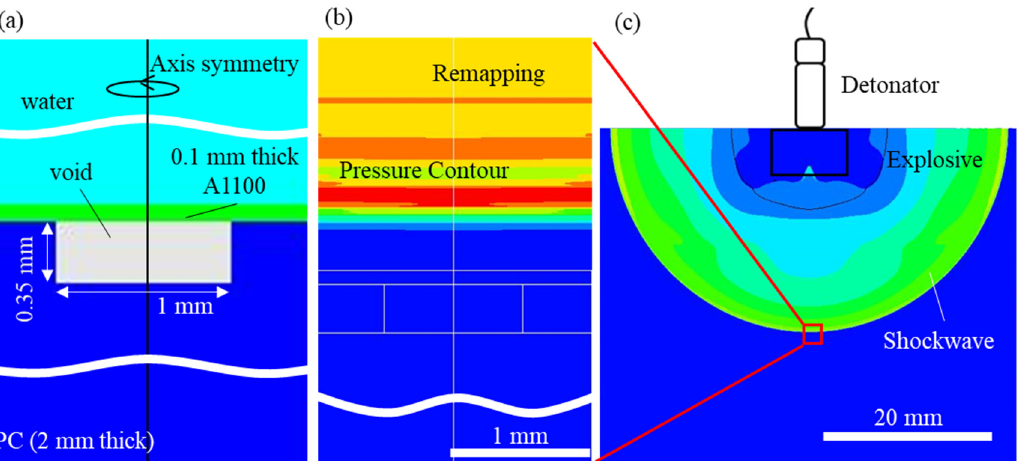
Figure 3. Numerical-simulation model using 2D Lagrangian and Eulerian solvers. ( a ) Dimensions and shapes of the PC mold, Al workpiece, and water. ( b ) Setting of the initial conditions. ( c ) Underwater shock-wave model consisting of the explosive and water.